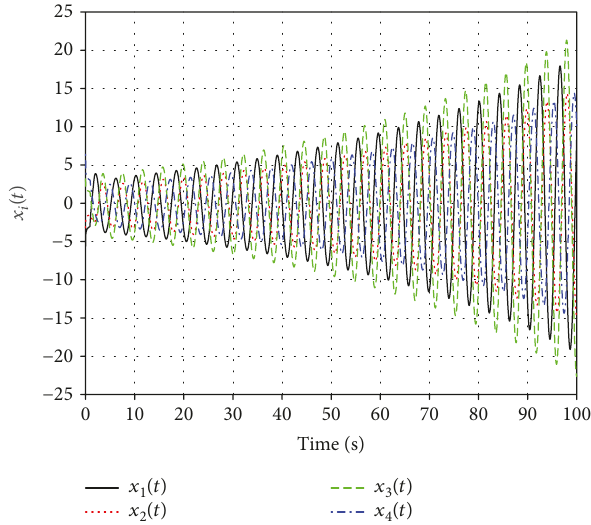
t applying the protocol in (7) i . 2